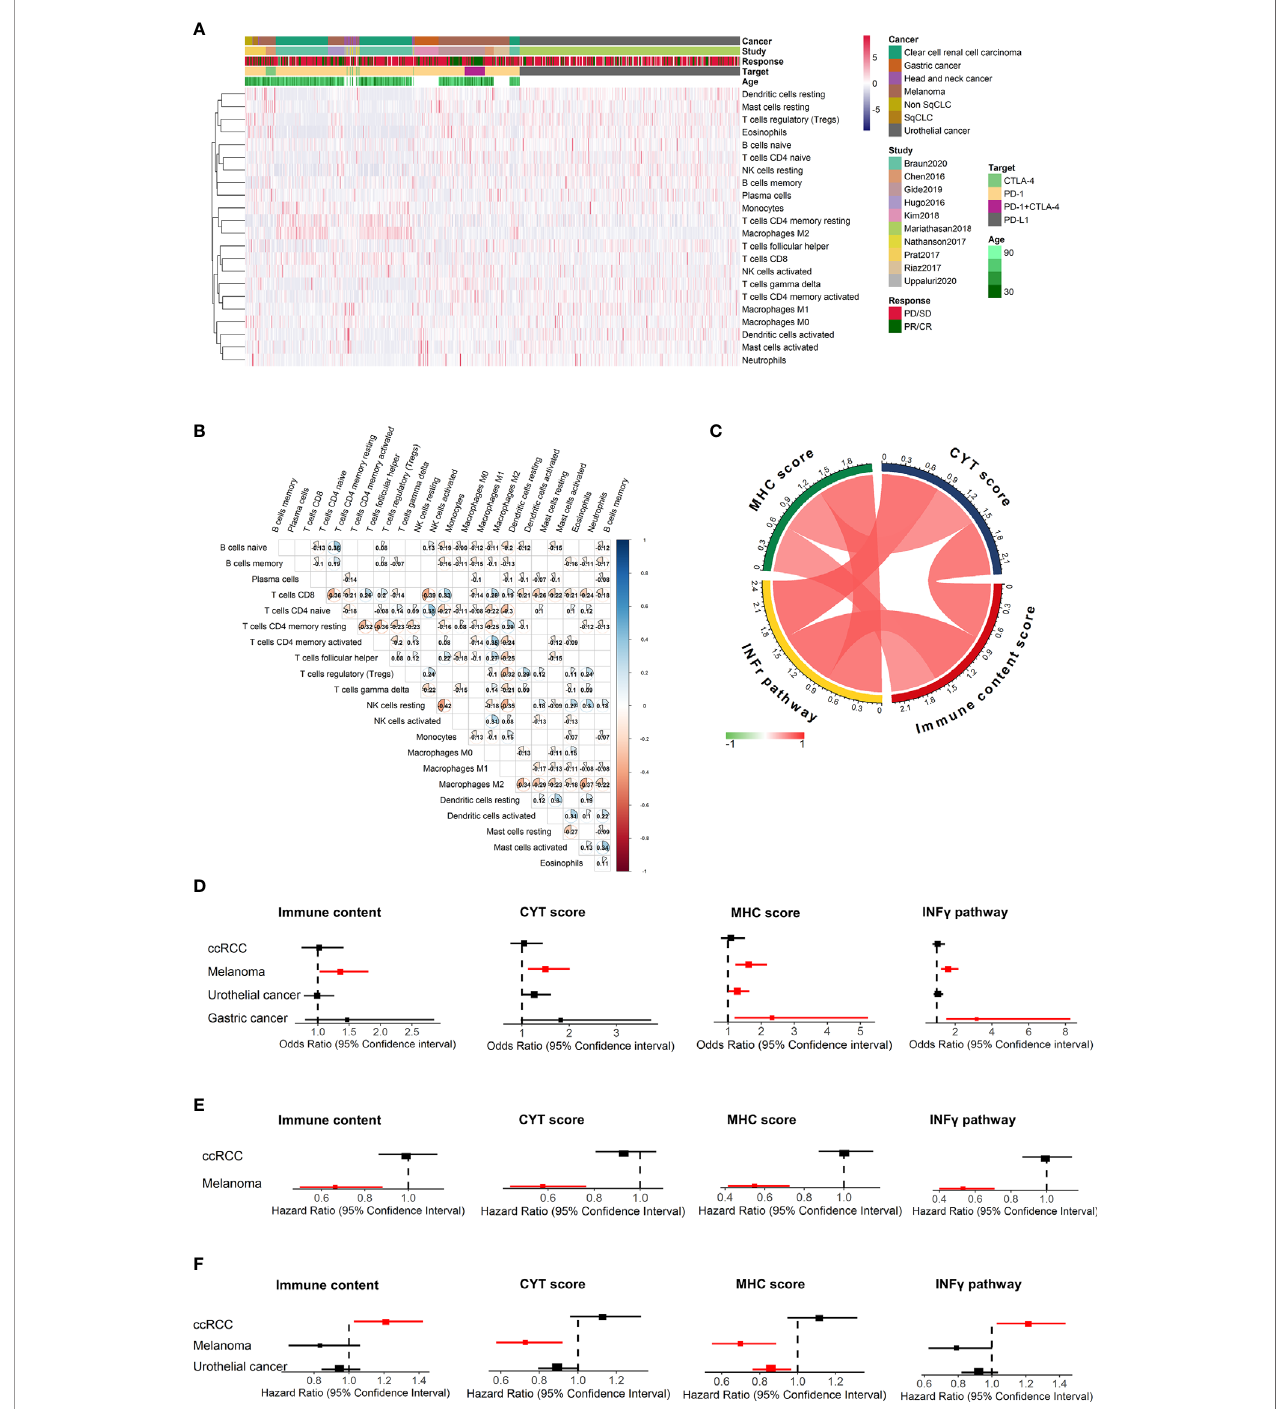
FIGURE 3 | Summary of the estimated relative fractions of 22 tumor-associated leukocytes in this study and immune response prediction signatures in melanoma. (A) Heatmap of unsupervised clustering of tumor-in fi ltrating immune cells in cohorts treated with ICIs. Rows and columns represent tumor-in fi ltrating immune cells and samples, respectively. (B) Heatmap of the correlation coef fi cient matrix of all 22 immune cell proportions across cancers. (C) correlation of immune scores. Forest plot demonstrating ORs (boxes) and 95% CIs (horizontal lines) for the association with response to ICI therapy for these four immune signatures (D) . Forest plot demonstrating HRs (boxes) and 95% CIs (horizontal lines) for the association with PFS (E) and OS (F) to ICI therapy for these four immune signatures. In the forest plots, signi fi cant associations were colored with red. NK cells, natural killer cells; sqCLC, squamous cell lung carcinoma; Non-SqCLC, non – small cell lung carcinoma; SD, stable disease; PD, progressive disease; PR, partial response; CR, complete